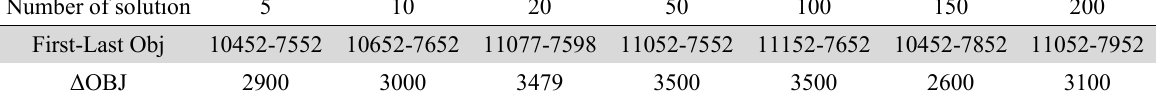
Results of running TS-SA to find approximate levels of factors of CCDCMS (small size) Number of solution